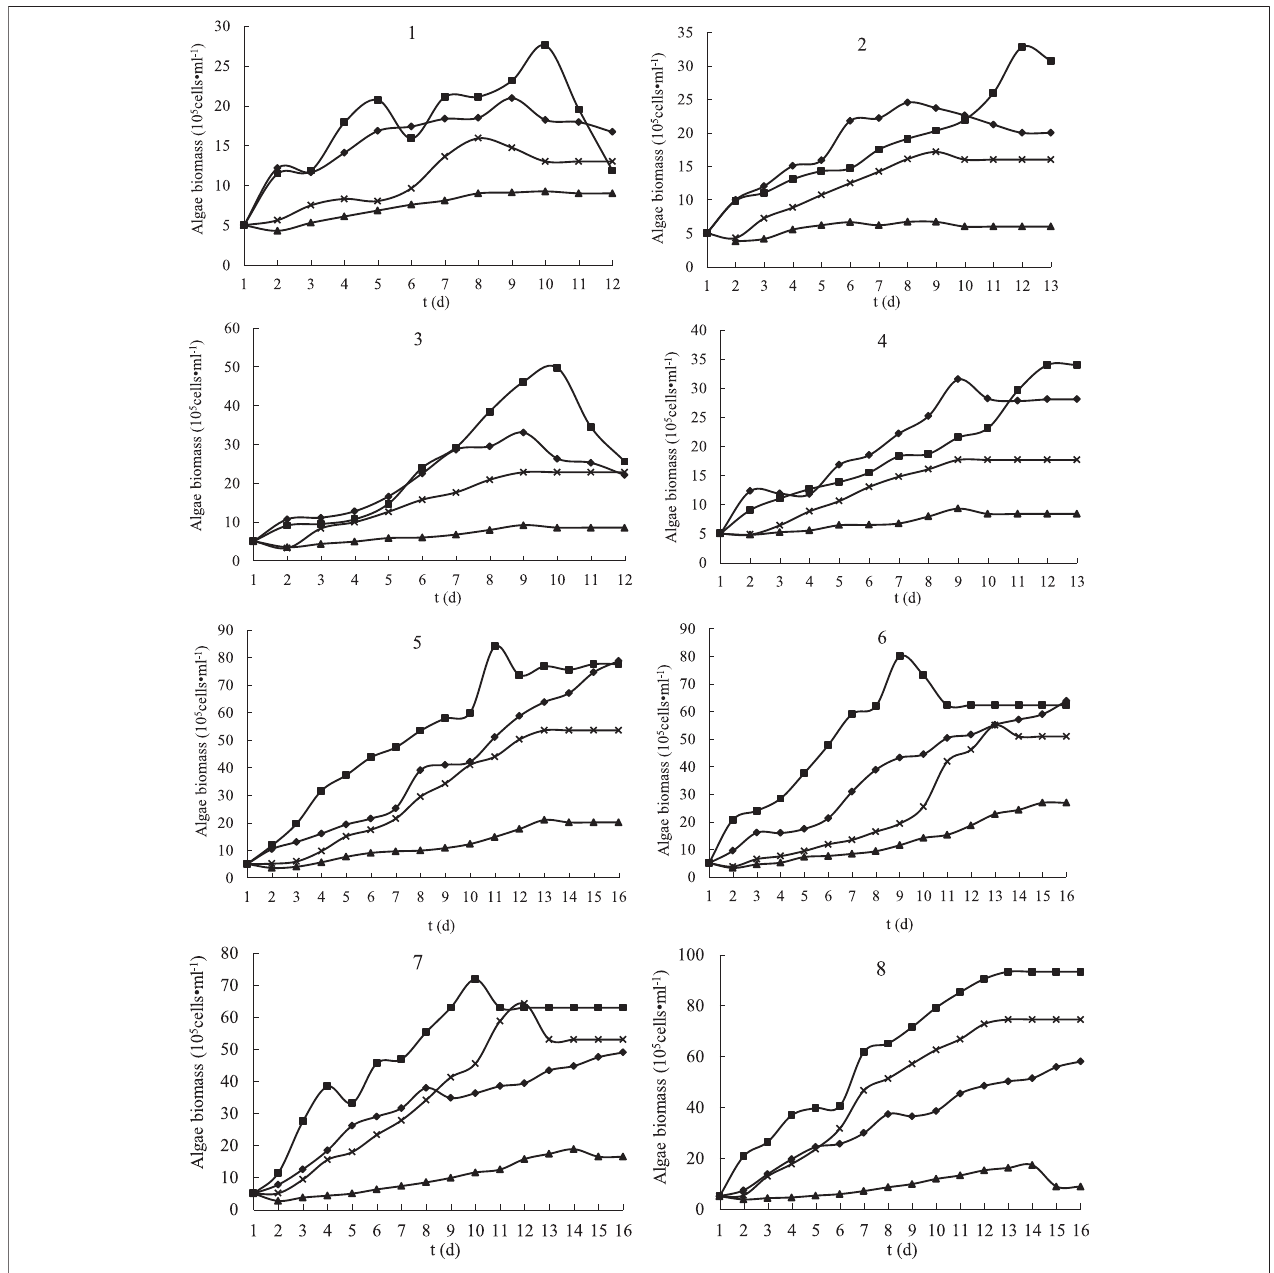
FIGURE 1 | Growth curves of Chlorella vulgaris and Anabaena sp. strain PCC in mono-culture and co-culture systems at different conditions (from Treatment 1 to Treatment 16).